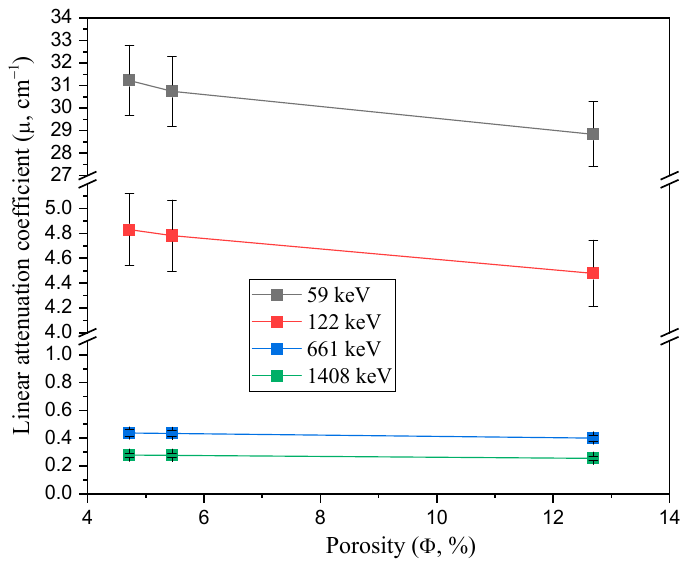
Figure 6. Dependence of the µ values on the porosity of the samples ( Φ , %).